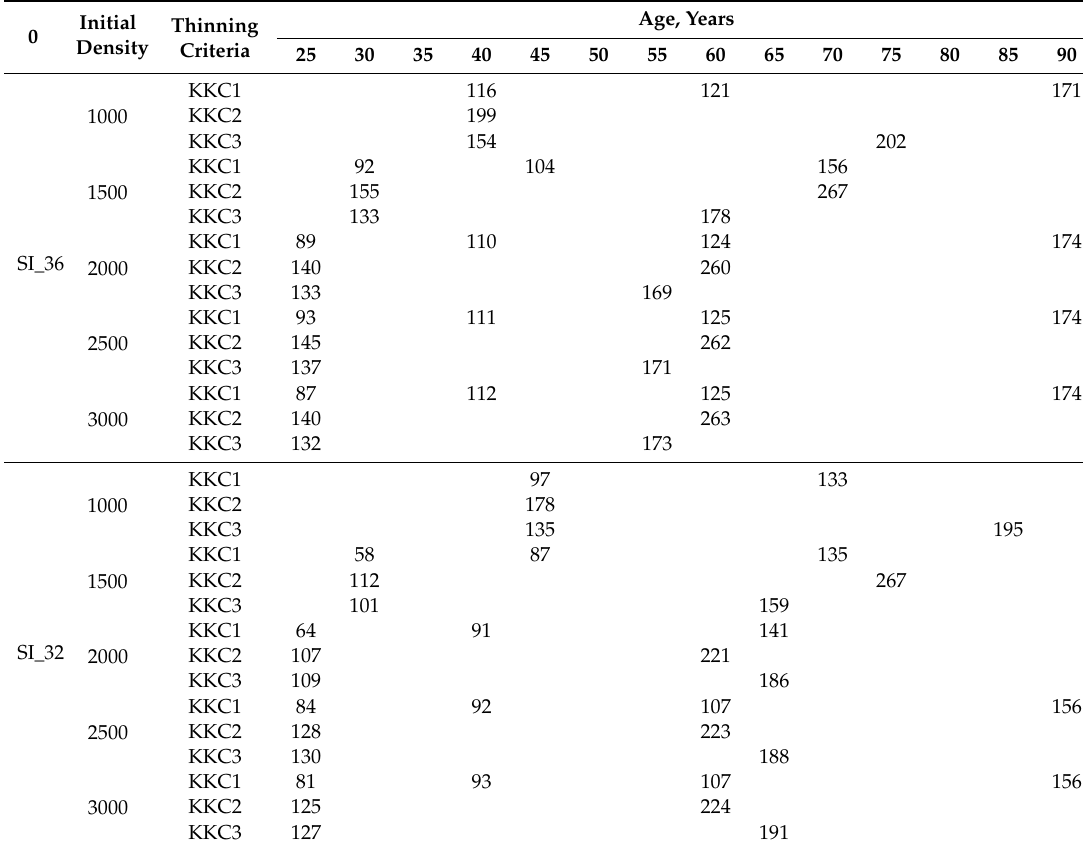
Table A1. Resulting commercial thinning